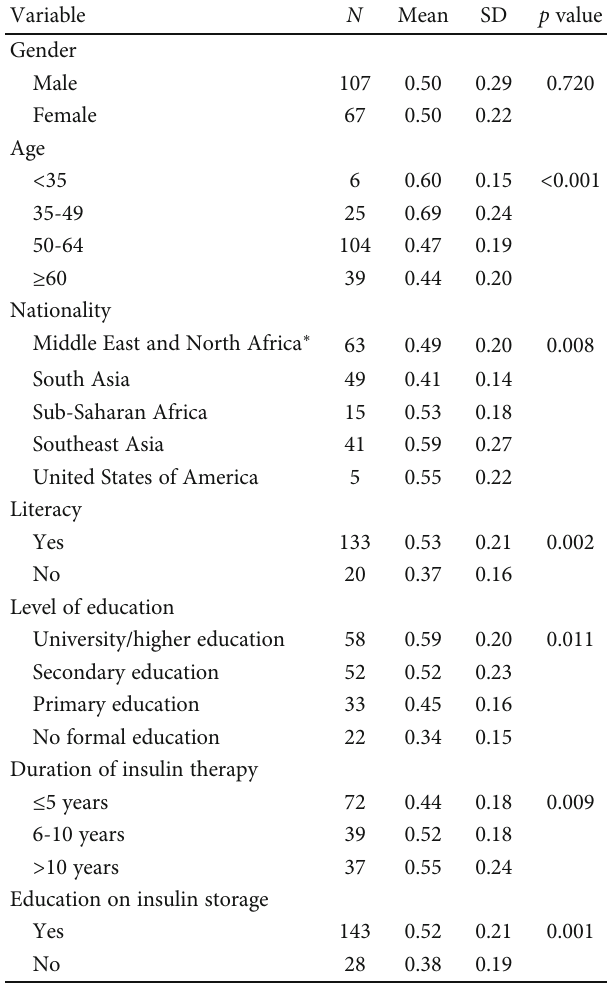
Figure 1: Level of insulin storage knowledge among diabetic Hajj pilgrims. Table 3: Variables and insulin storage mean knowledge scores among diabetic